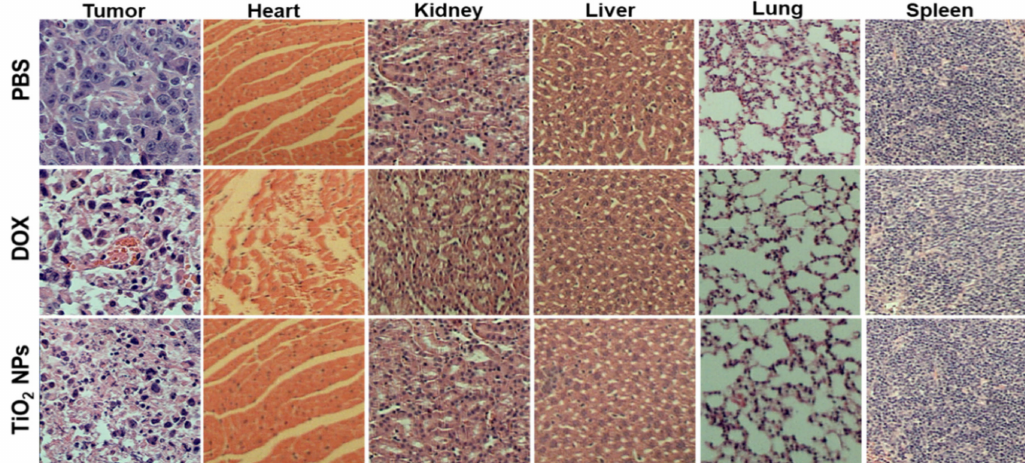
Figure 10. Histopathological analysis (at day 21) of the induced-breast tumor tissue and major surrounded organs of breast tumor-bearing BALB/c mice, after treatment with either PBS (1X, pH 7.4; 20 mL/kg/day), free DOX (5 mg/kg/day), or TiO 2 NPs (5